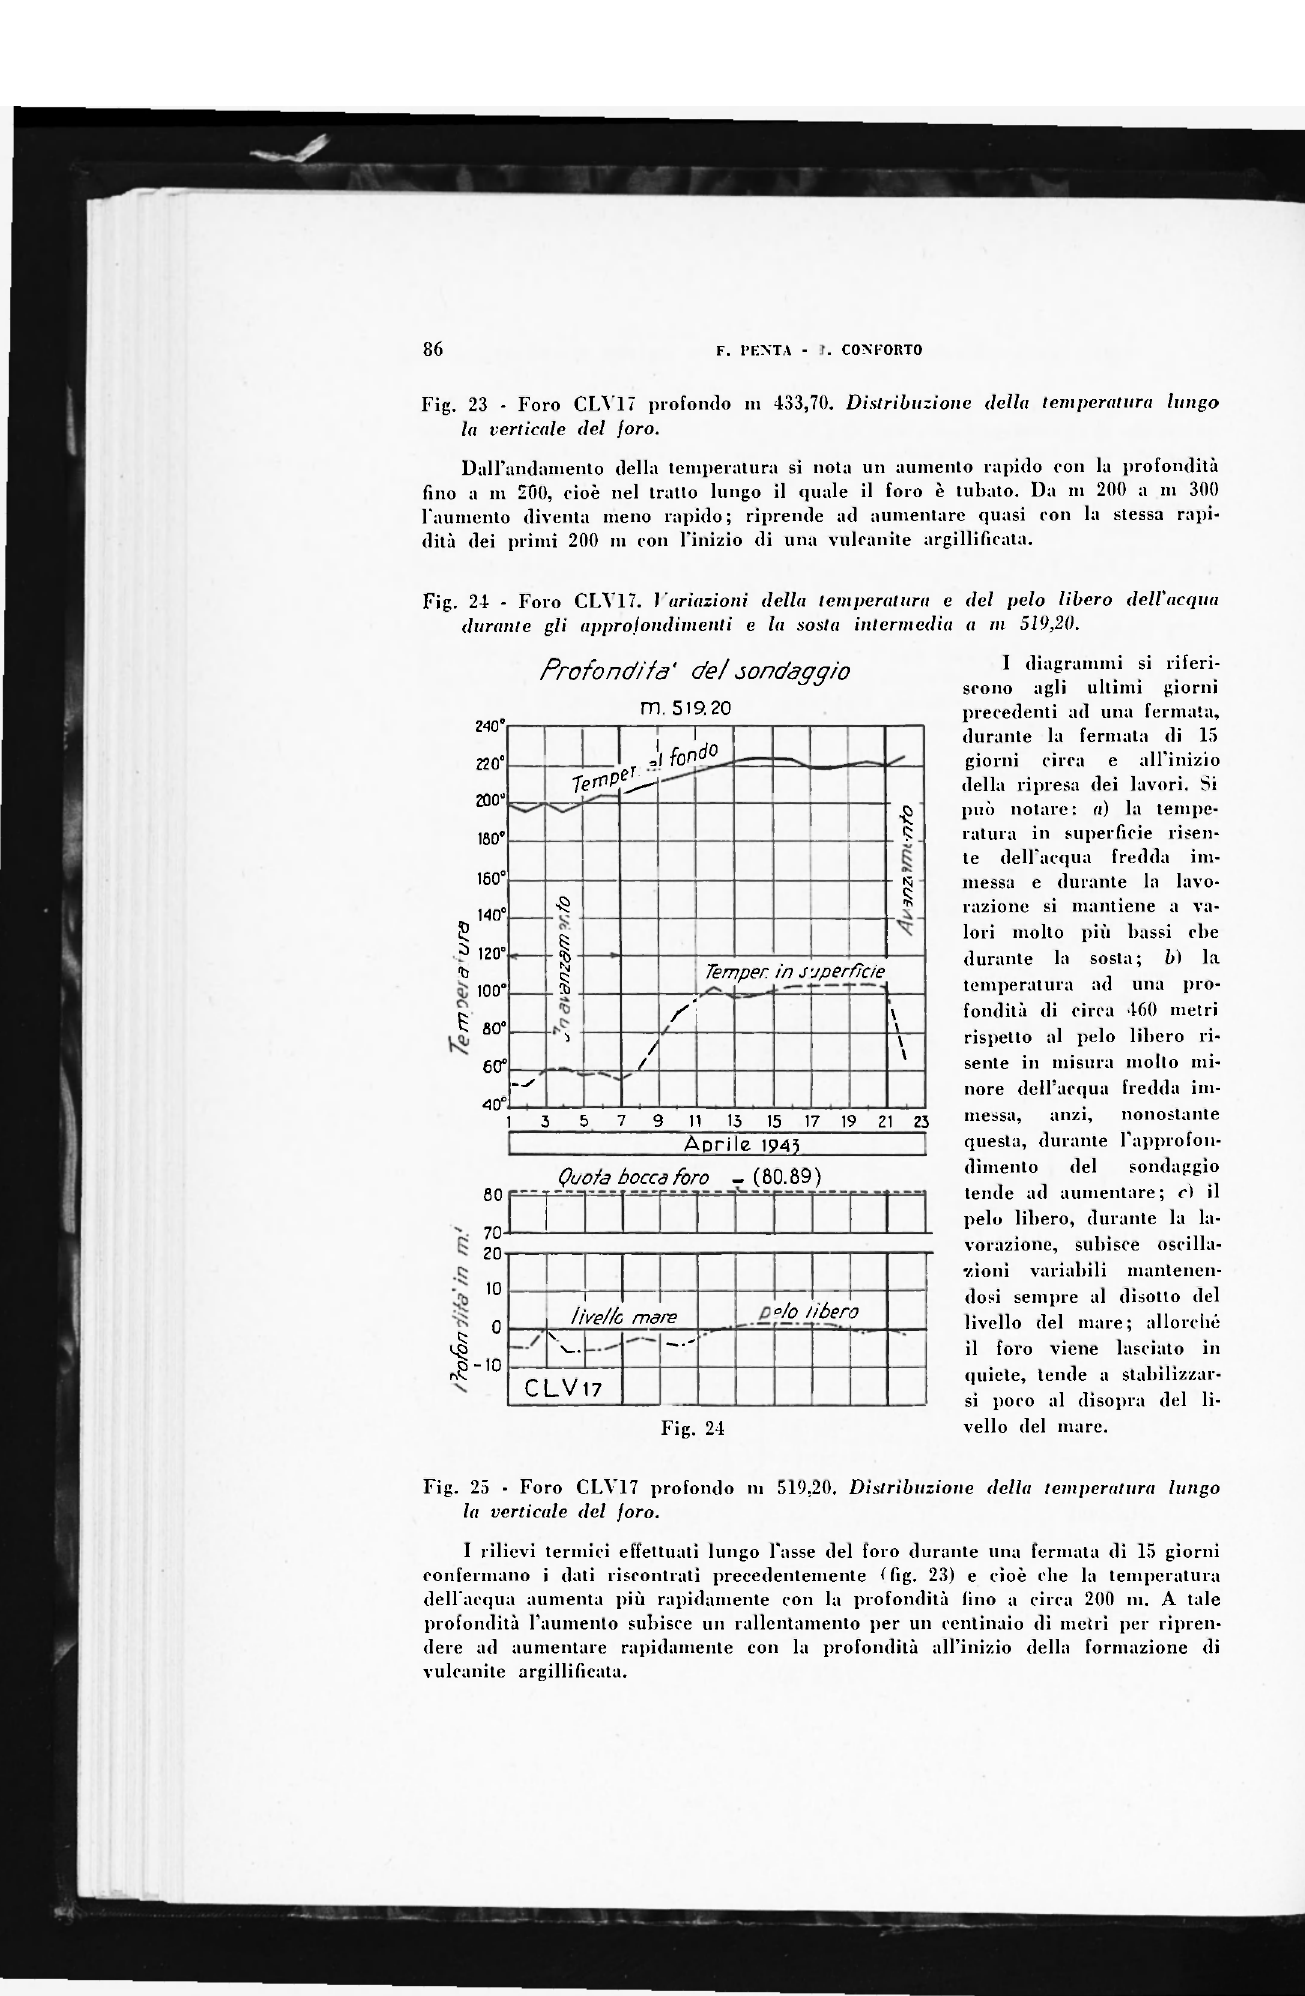
Fig. 25 • Foro CLV17 profondo ni 519,20. Distribuzione della temperatura lungo la verticale del